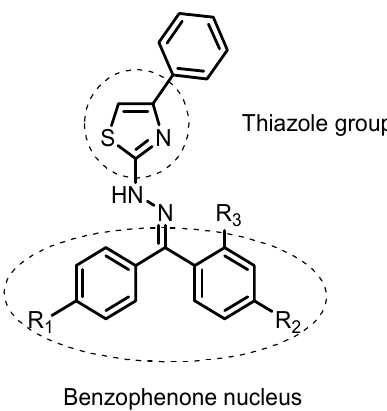
Figure 1. General structure of planned compounds by molecular hybridization.